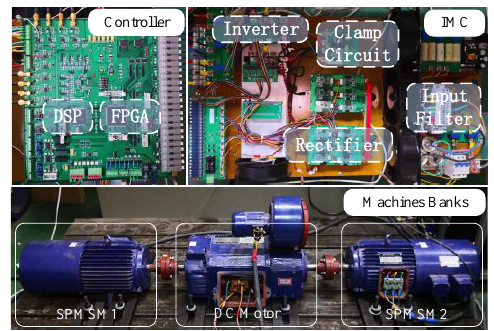
Figure 12. The experiment platform.